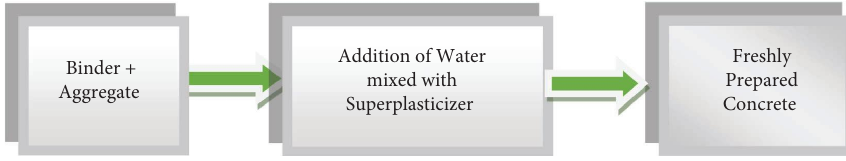
Figure 2: Mixing procedure for